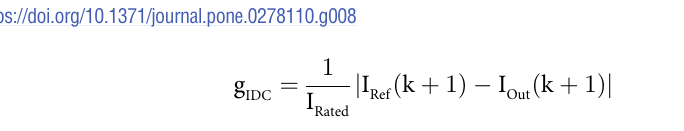
Fig 8. MPC block diagram for GFE operation through DC/DC